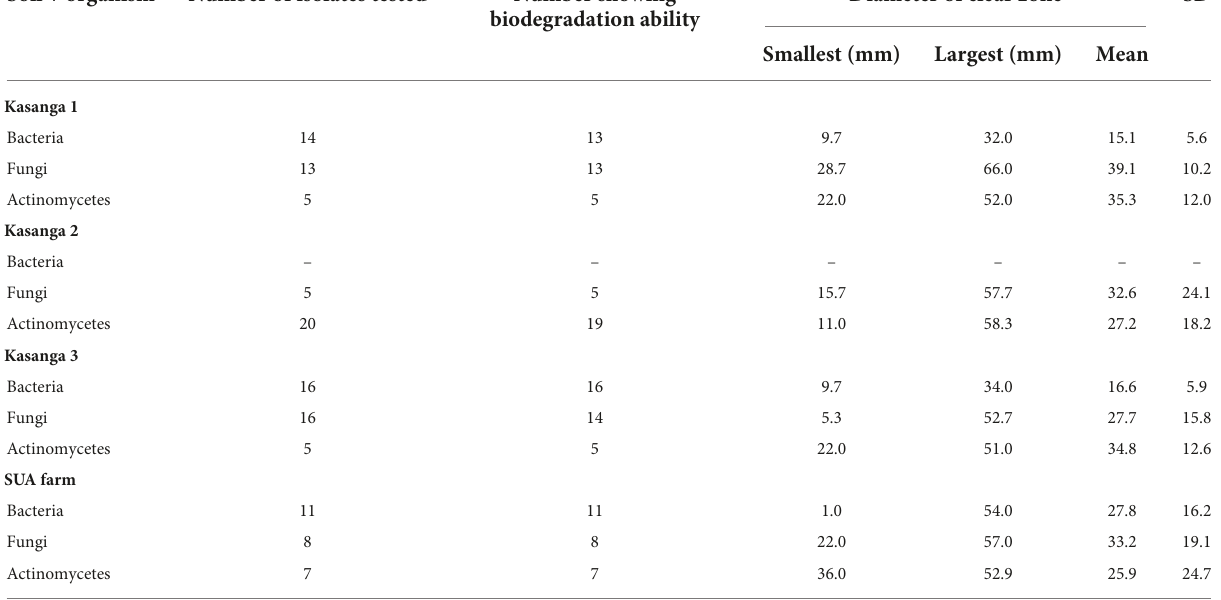
TABLE 2 Screening the abilities of isolated bacteria, fungi, and actinomycetes from four different soils in degrading ground plastic bags. Soil + organism Number of isolates tested Number showing Diameter of clear biodegradation ability